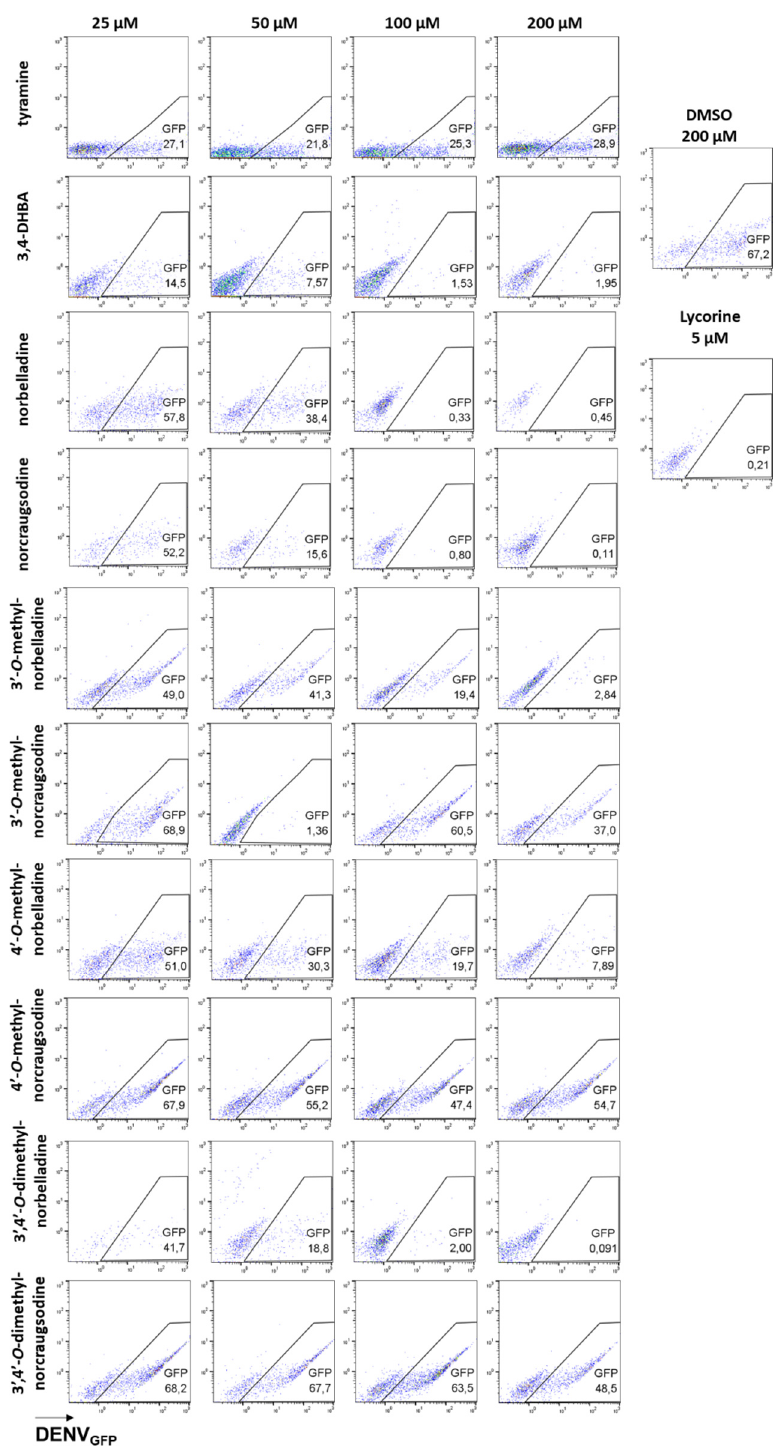
Figure A2. Antiflaviviral effects of norbelladine precursors and derivatives on DENV GFP . The antiviral activity against DENV GFP was evaluated 72 h post-infection using Huh7 cells via flow cytometry at four concentrations (25, 50, 100, and 200 µ M) of norbelladine precursors and derivatives. Lycorine (5 µ M) was included as the positive control and DMSO (200 µ M) as the negative control. Representative dot plots are presented.